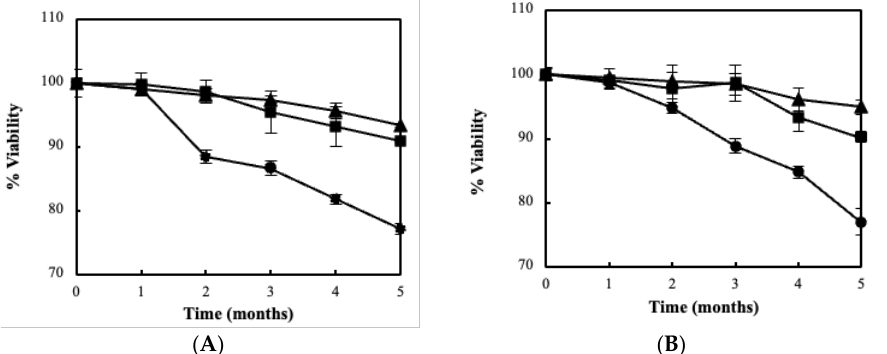
Figure 3. Viability of free ( ● ) and immobilized cells of L. pentosus B329 ( A ) and L. plantarum 820 ( B ) on bacterial cellulose ( ▲ : BC film and ■ : blended BC) during 5 months of storage at 4 °C.